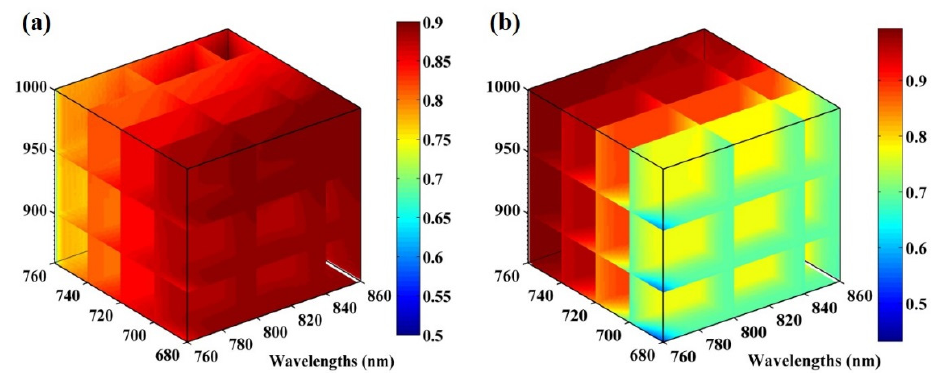
Figure 4. The correlation between TVI-like indices and vegetation parameters. ( a ) Correlation between the LAI and wavelengths, ( b ) correlation between the CCD and wavelengths.